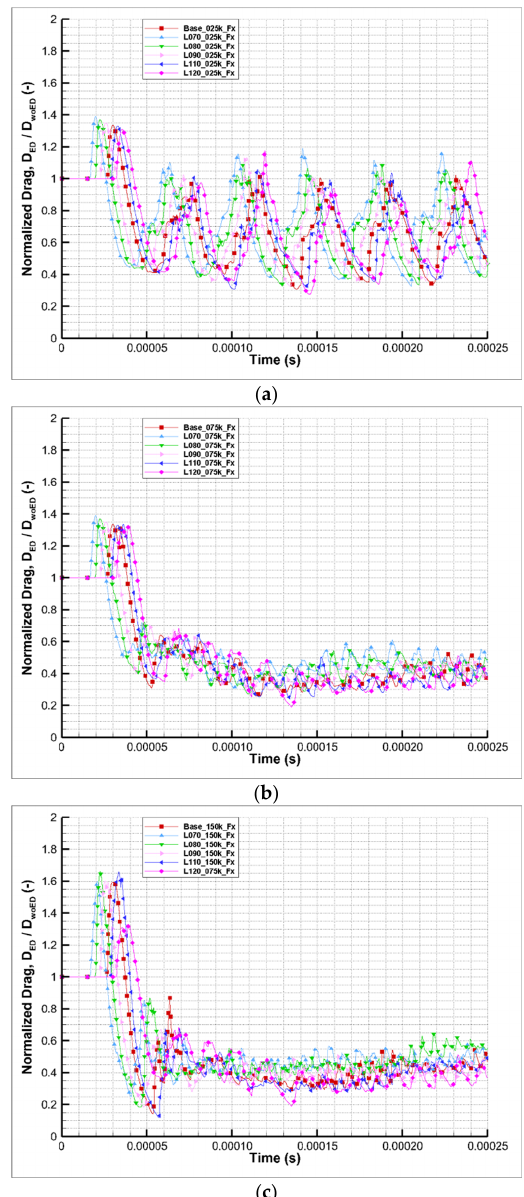
Figure 10. Normalized drag vs. focal distance for various deposition frequencies ( a ) 25 kHz, top; ( b ) 75 kHz, middle; ( c ) 150 kHz, bottom. ( b ) 75 kHz, middle; ( c ) 150 kHz,